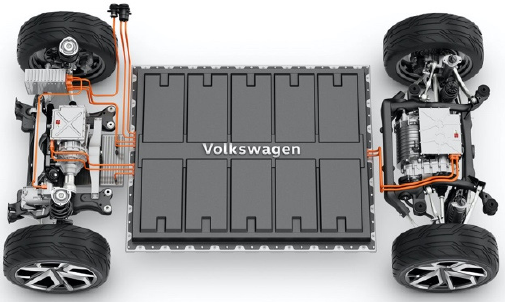
Figure 3. VAG–MEB EV platform. Source: VAG™ 2021.